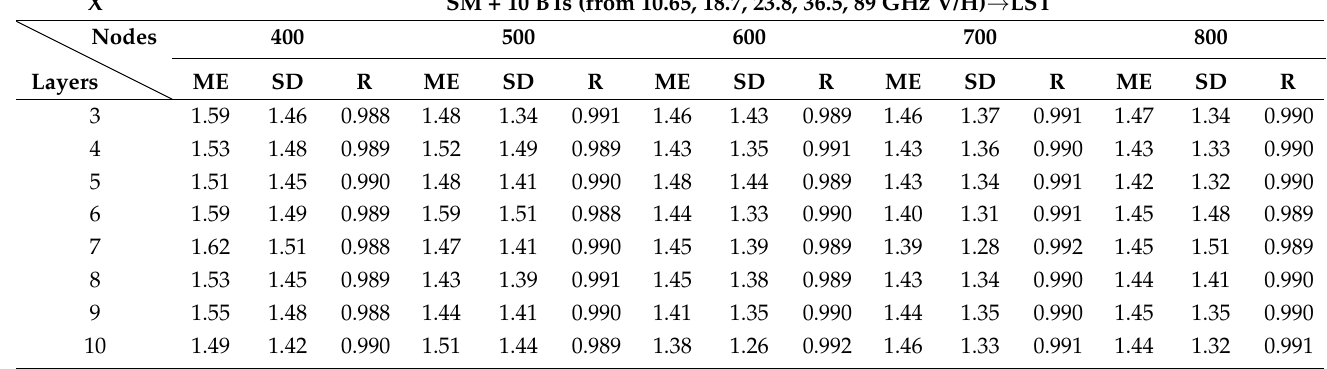
Table 10. SM and ten channels are used to retrieve LST (SM and brightness temperature combination of ten